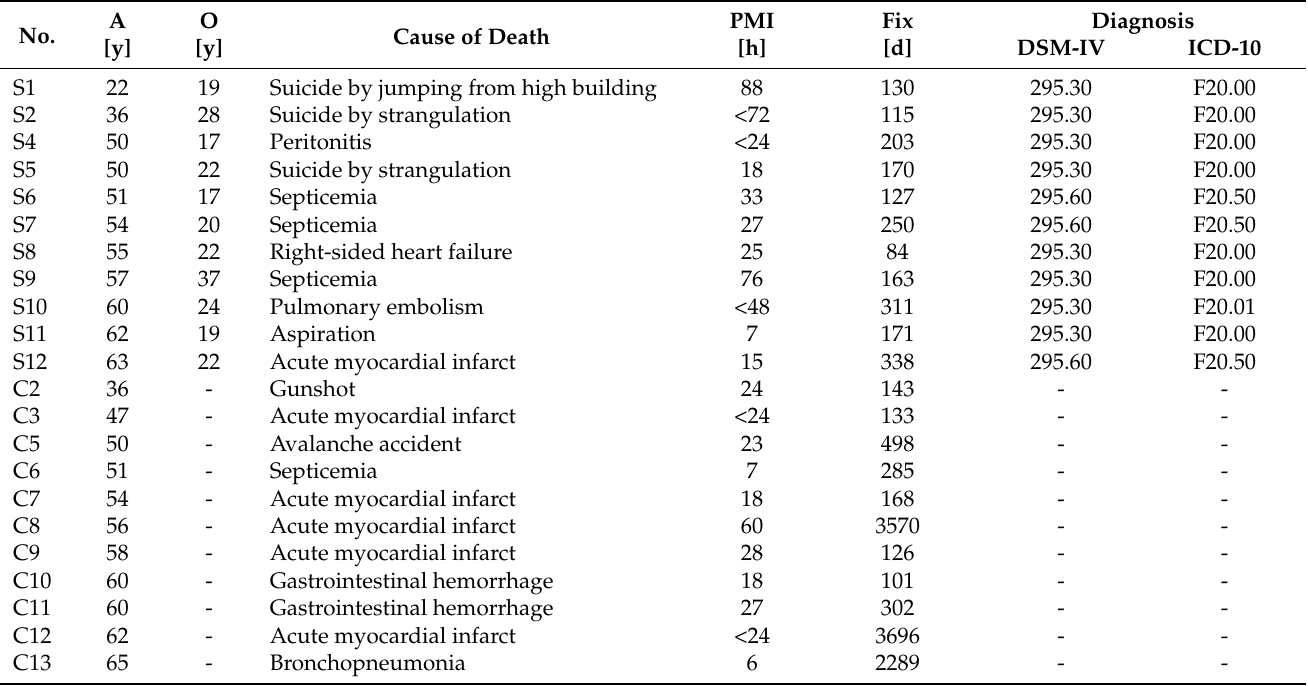
Table 1. Clinical characteristics of study